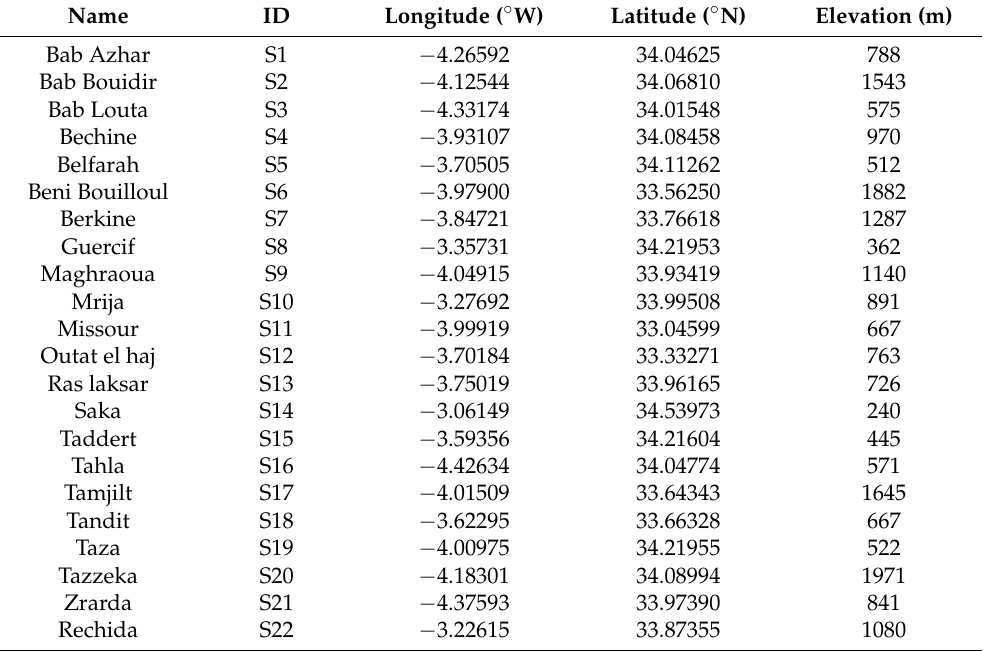
Figure 2. Data availability per year. The green and red lines mark the desired and critical number of the data availability threshold, respectively. Table 1. Geographical location of stations; code of the coordinate system used is